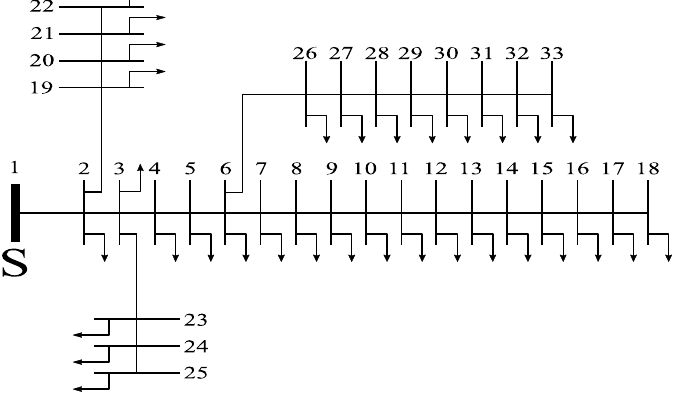
Figure 9. Energies 2018 , 11 , x